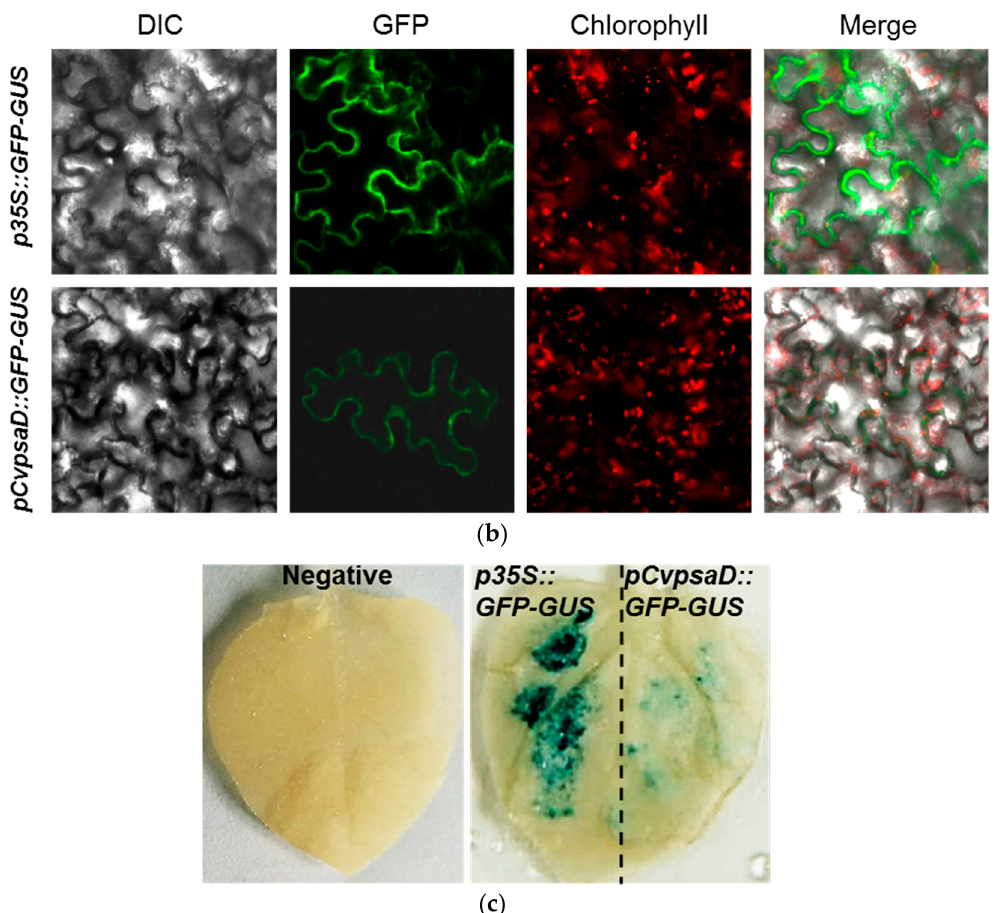
Figure 5. Evaluation of the CvpsaD promoter function in higher plants. Green fluorescent protein (GFP) analysis and the β -glucuronidase (GUS) histochemical assay were performed on the infiltrated leaves. ( a ) Schematic representation of promoter cassettes conjugated with the GFP-GUS fusion gene. ( b ) Green fluorescence in epidermal cells and ( c ) GUS reporter assay in leaf tissue of N. benthamiana . Transient expression of GFP-GUS three days after infiltration with Agrobacterium harboring GFP-GUS vector.